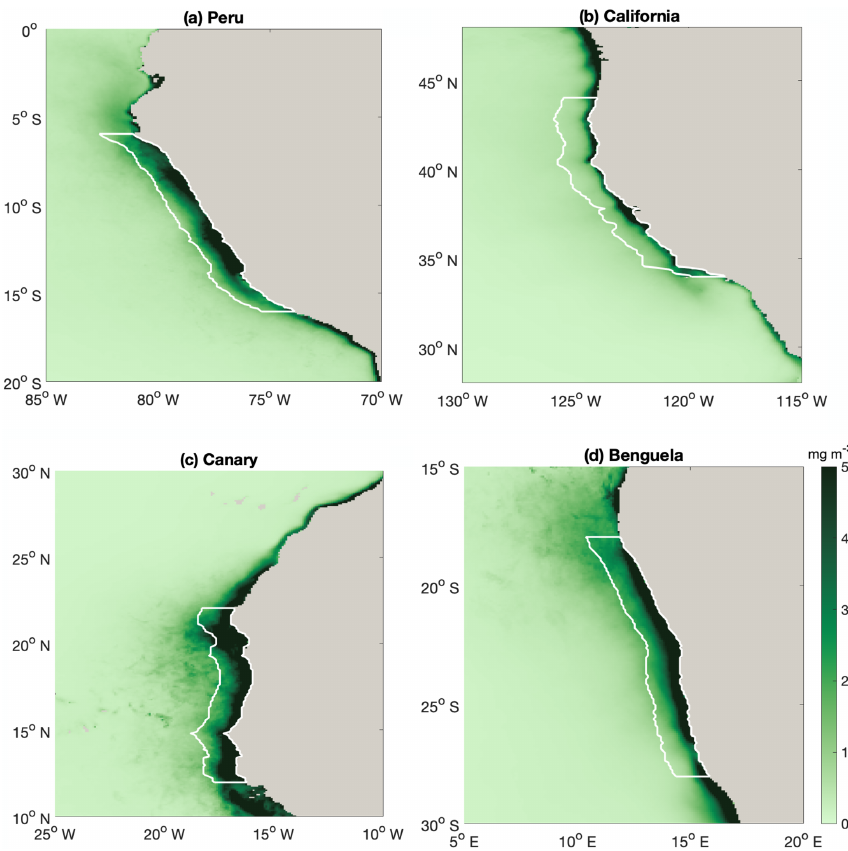
Figure A2. Map of annual mean surface chlorophyll (mgchlm − 3 ), with white lines highlighting the regions that we average over in our analyses in Fig. 2. Coastal EBUS regions picked here are the same as Chavez and Messié (2009).